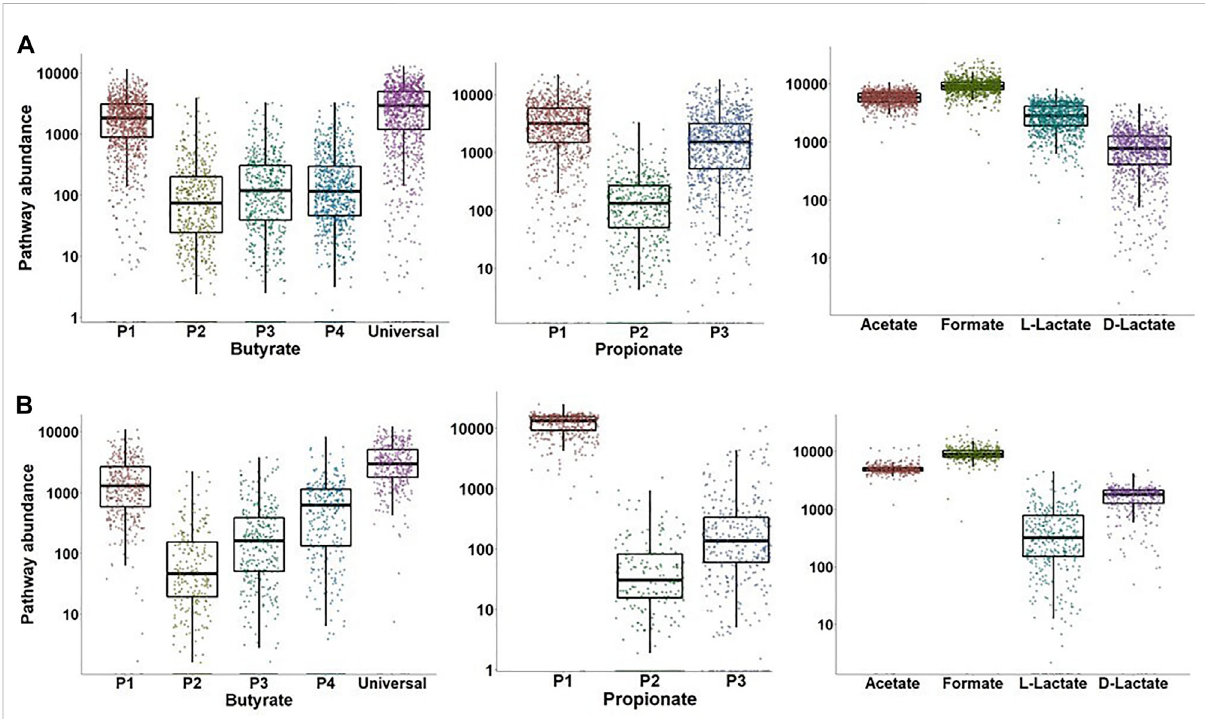
FIGURE 7 Distribution of metagenomic abundances for SCFA synthesis pathways in HGM samples from TEDDY (A) and IBD (B) datasets. Pathway abundanceswerecalculatedas asumofTMM-normalizedcounts forselectedsignaturegenesineachSCFApathway(seeSupplementary